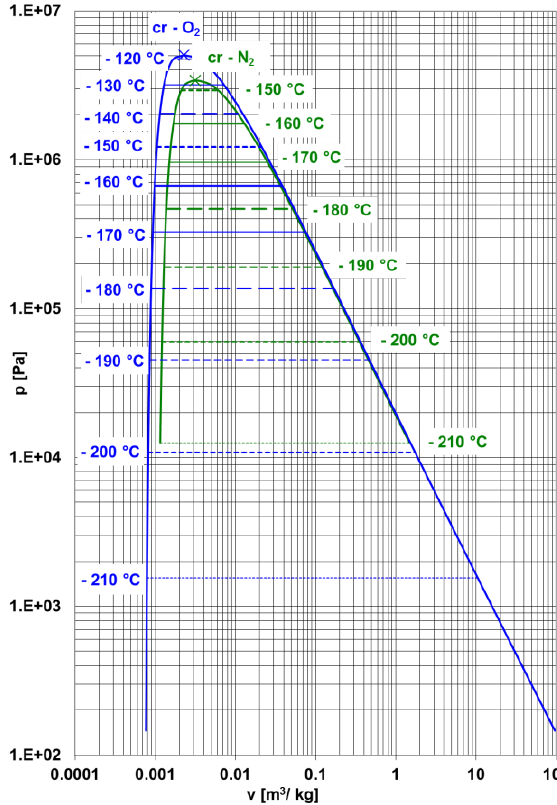
Fig. 2. Liquid and vapor saturation curves in p v  diagram for dry air components: nitrogen cr -critical point .